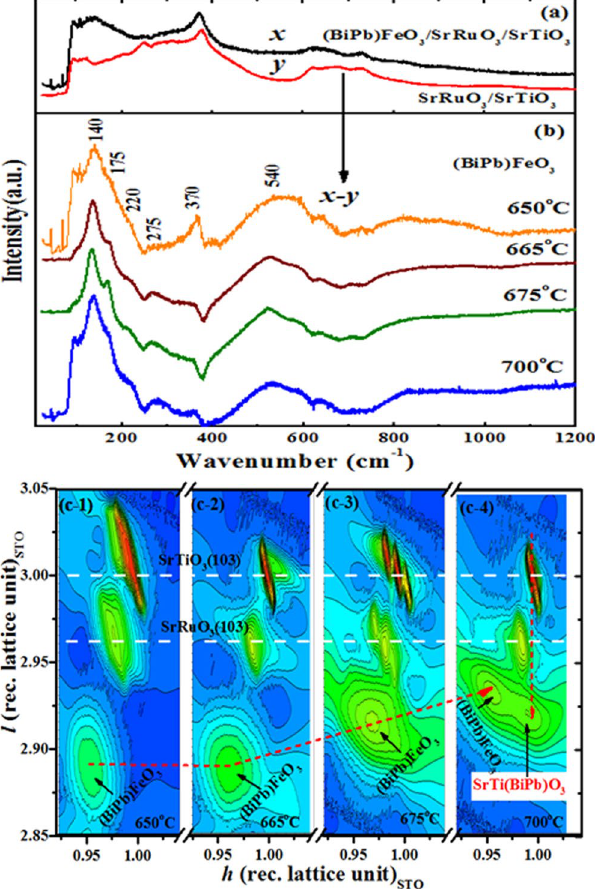
Figure 1. Raman spectroscopy and high resolution X-ray reciprocal space mapping of (BiPb)FeO 3 /SrRuO 3 / SrTiO 3 hetero-structures. ( a ) Raman spectra of (BiPb)FeO 3 /SrRuO 3 /SrTiO 3 hetero-structure for T g = 650 °C ( x ) and the bottom SrRuO 3 /SrTiO 3 structure ( y ). ( b ) Raman spectra represent only contributions from (BiPb)FeO 3 layers ( x-y ) at different T g , showing only a few Raman modes when compared to bulk BiFeO 3 . (c: 1–4) RSMs around (103) planes of (BiPb)FeO 3 layers 9 and bottom SrRuO 3 /SrTiO 3 structure; with increasing T g , the (BiPb) FeO 3 peak splits into two peaks (indicated by vertical red arrow).